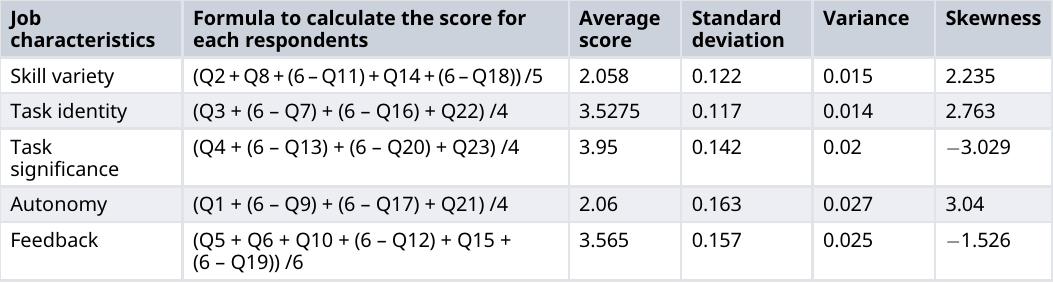
Table 3. Calculation of job characteristic scores for 100